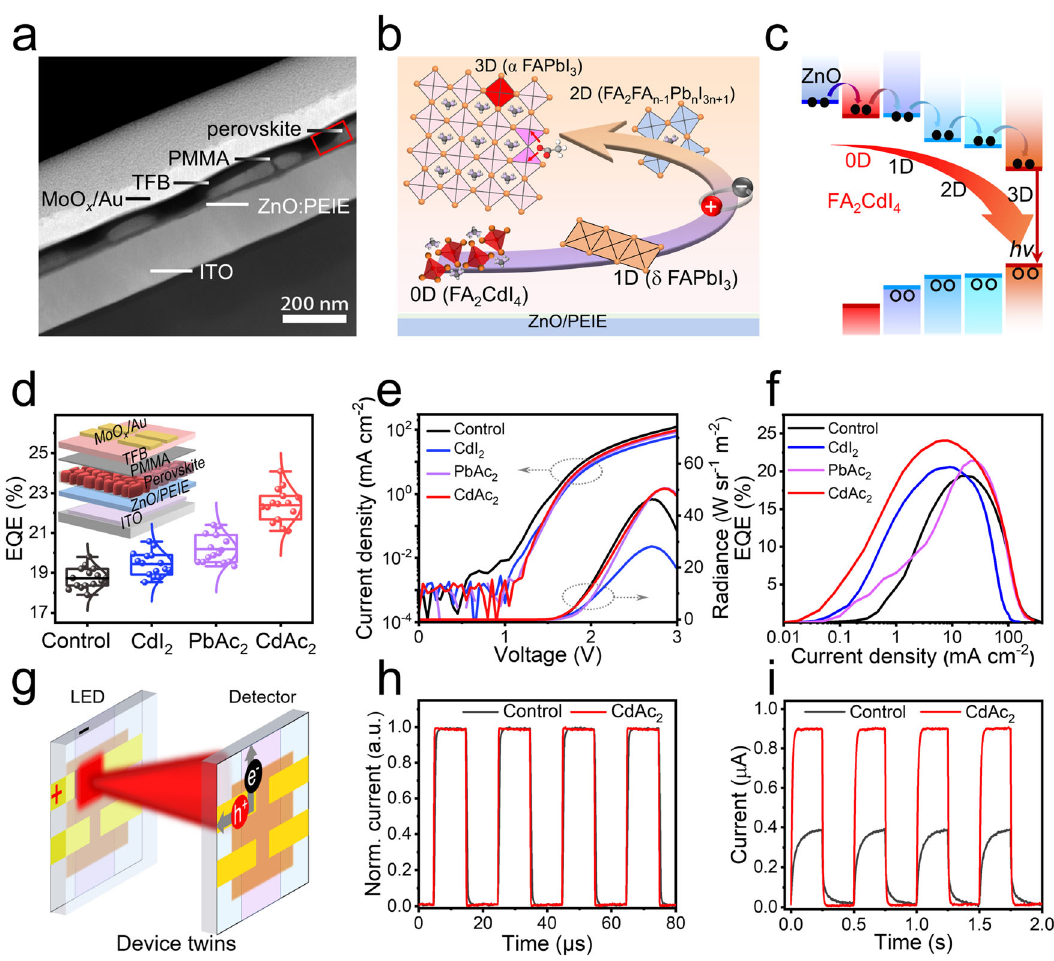
Fig. 4 | Schematic diagram of energy transfer mechanism and device perfor- mance. a HAADF-STEM image of a representative device. b Schematic diagram of theenergytransferprocessinperovskitelight-emittinglayers. c Schematicdiagram of the excited carrier transfer in an enhanced energy funnel structure. d Statistical distribution of the peak EQE for control and PMs-added devices. Insert: device